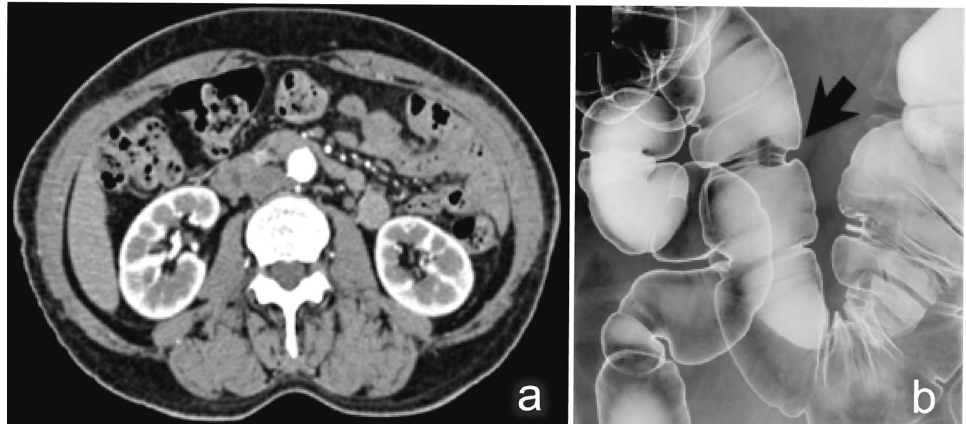
Fig. 2 Individual imaging findings during the initial examination. a Computed tomography revealed no remarkable abnormality and no evidence of wall thickening in the transverse colon, lymph node metastasis, and distant metastasis. b Barium enema examination revealed an arc-shaped deformation in the transverse colon, confirming that the lesion was a type II tumor